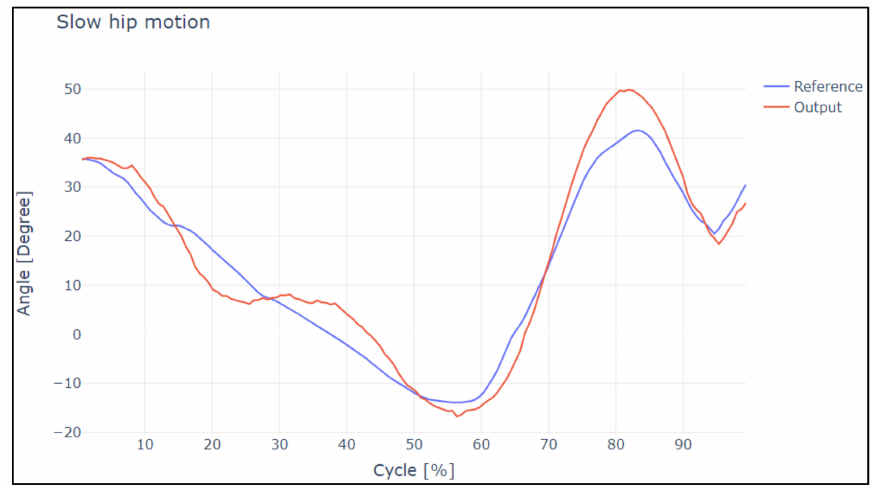
Figure 12. Reference curves vs. output during slow hip motion.